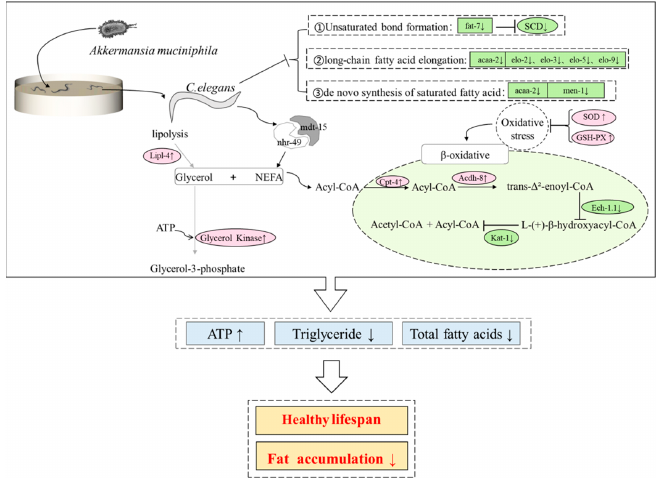
Figure 7. The molecular mechanism of p ‐ AKK reduces fat accumulation.